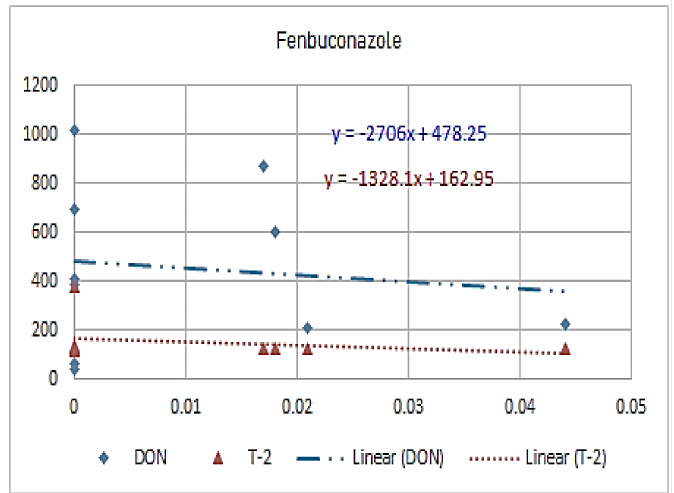
Figure 8. Therelationbetween fenbuconazoleresidue(ppb)and DONandT-2 toxin(ppb)in